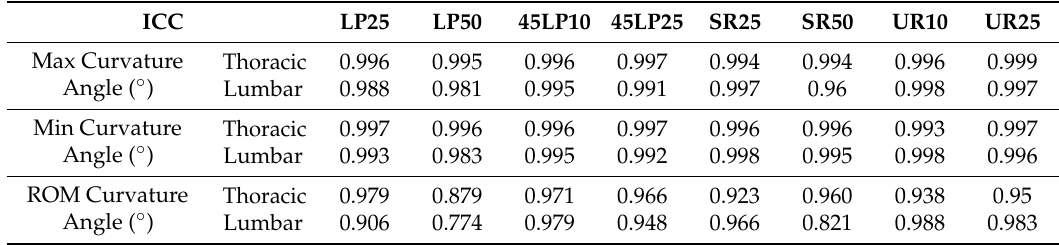
Table A8. ICC(3,k) values of the maximal, minimal and range of motion ROM of the